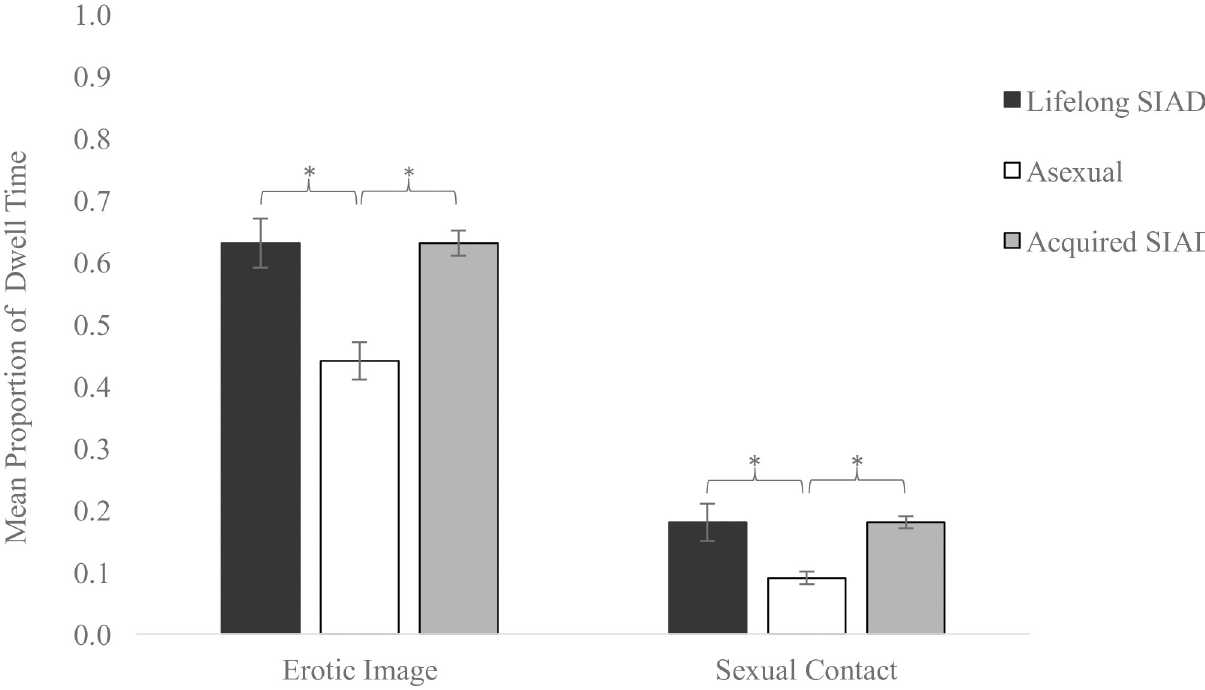
Fig 3. Proportion of dwell time to the erotic image and area of sexual contact. Asexual individuals ( n = 39) had shorter dwell times (s) to the erotic image and area of sexual contact relative to women with lifelong SIAD ( n = 9) and women with acquired SIAD ( n = 16). Error bars represent standard error of the mean. � p <